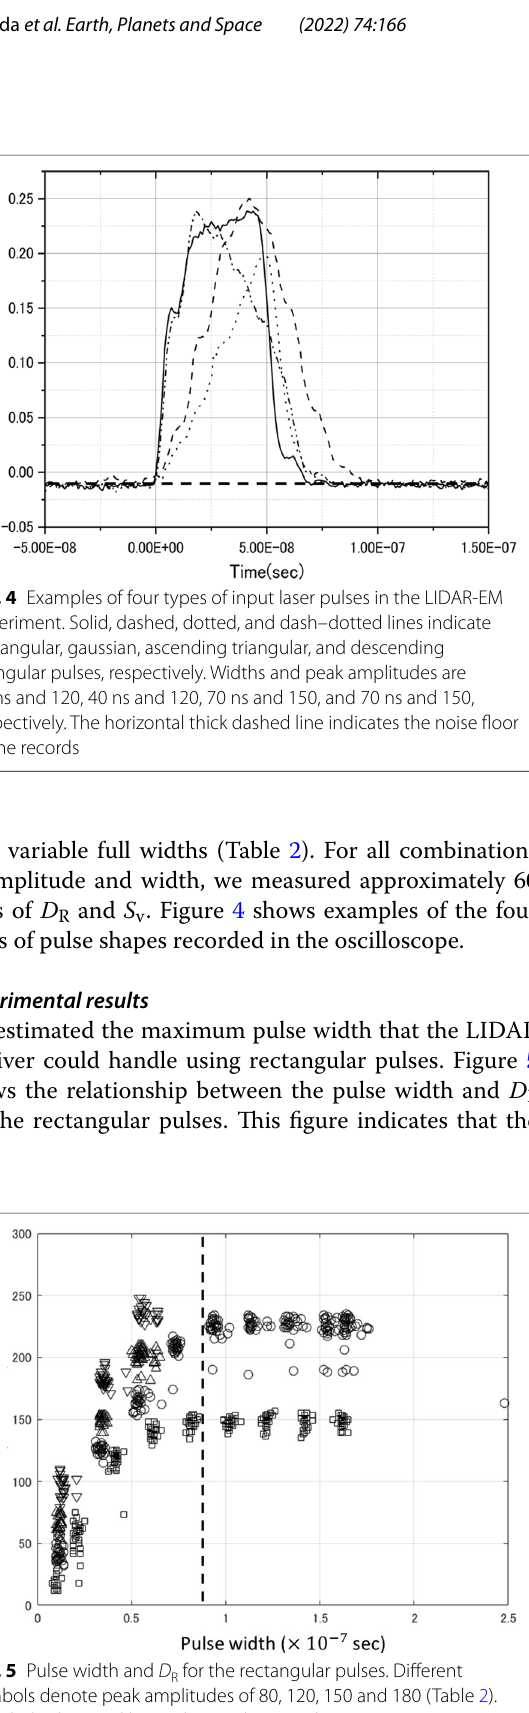
Fig. 5 Pulse width and D R for the rectangular pulses. Different symbols denote peak amplitudes of 80, 120, 150 and 180 (Table 2). The dashed vertical line indicates the 90 ns limit